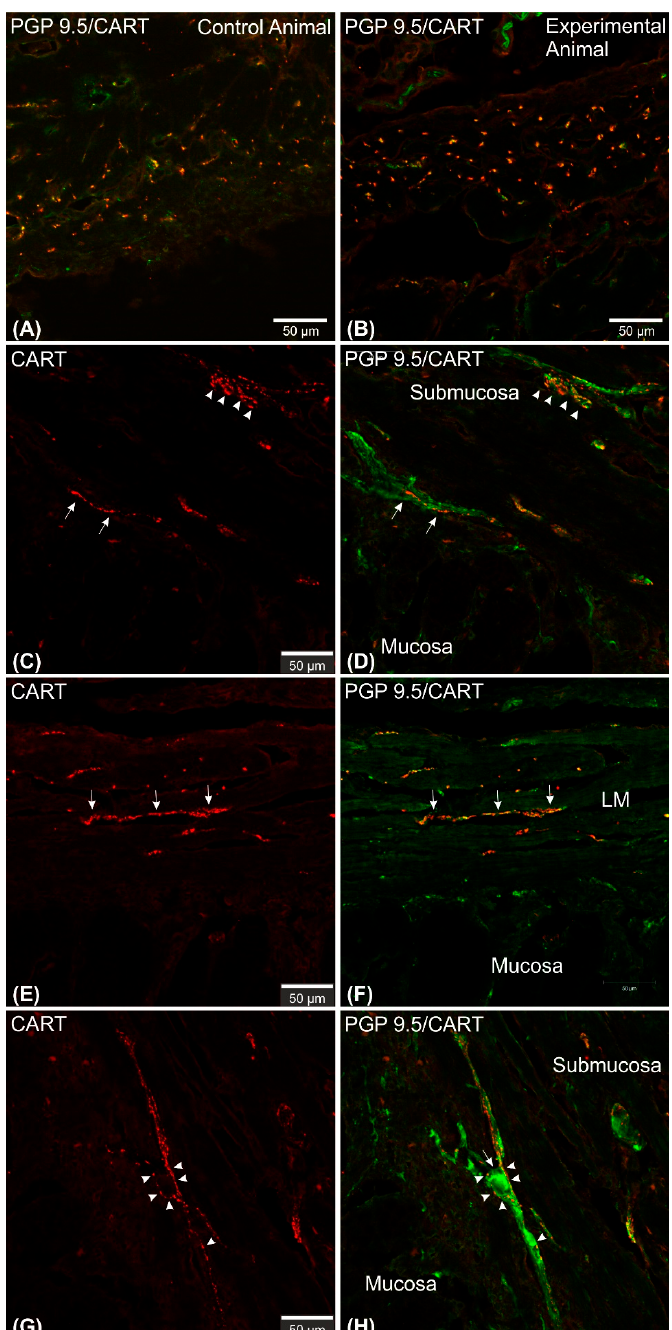
Figure 8. Set of exemplary microphotographs showing CART/PGP 9.5 immunolabelled neuronal fibers in the longitudinal muscle layer ( A , B ) and in the submucosa and lamina muscularis mucosae ( C – H ). ( A , B ) Evenly dispersed, transversally cut neuronal fibers observed in the control ( A ) and experimental ( B ) animals. ( C , D ) Bundles of highly fluorescent varicose nerve fibers located within submucosa (arrowheads) and sparse nerve fibers observed in the lamina muscularis mucosae (arrows) in both studied animal groups. ( E , F ) Thick, highly immunoreactive fibers running parallel to the muscle fibers of muscularis mucosae (arrows) sporadically observed in both groups of animals. ( G , H ) CART-immunofluorescent nerve fibers (arrowheads) attaching and encircling perikaryon located in the lamina muscularis mucosae (arrow) observed in both studied groups of pigs. Scale bars included in the pictures. CART—red channel, PGP 9.5—green channel. In ( A , B , D , F , H ) both channels overlapped. LM—lamina muscularis